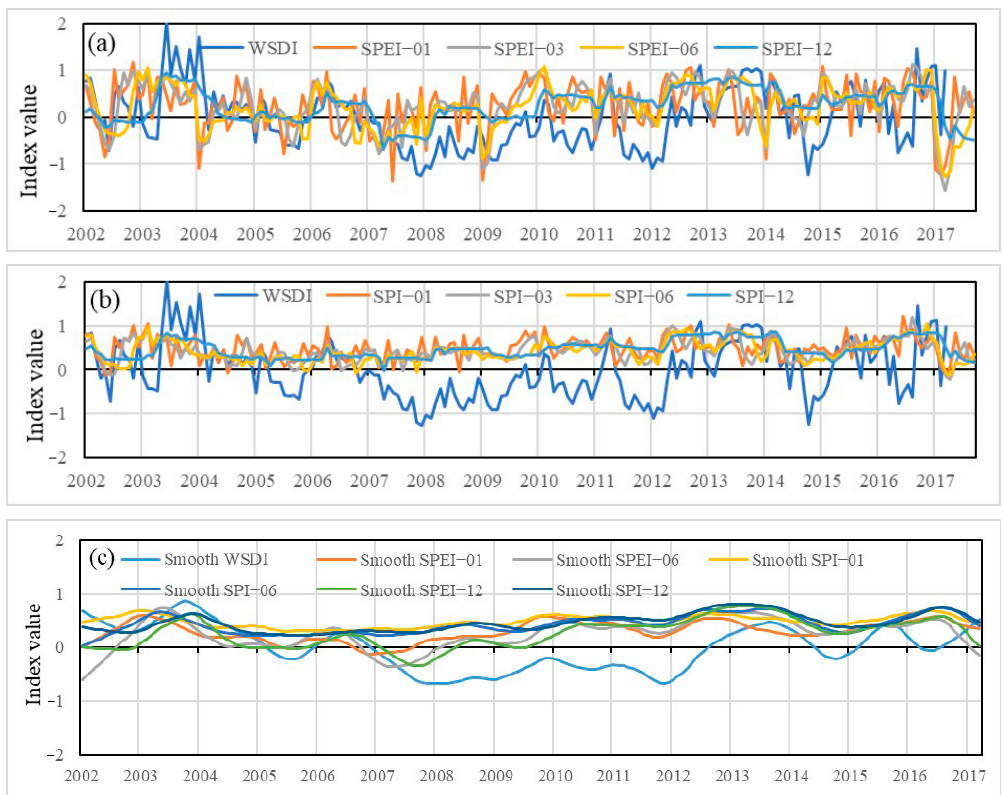
Figure 8. Comparisons between water storage deficit index (WSDI) and two other drought indices (SPEI ( a ) and SPI ( b )) and after smoothing ( c ) in 1 − ,3 − , 6 − , and 12 − month scales.